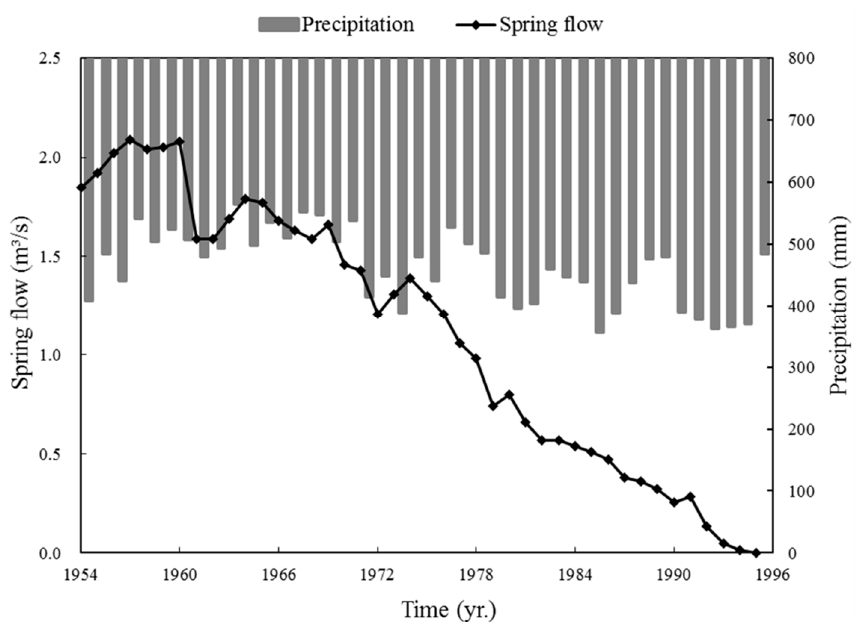
Figure 3. Spring flow and precipitation of Jinci Springs.